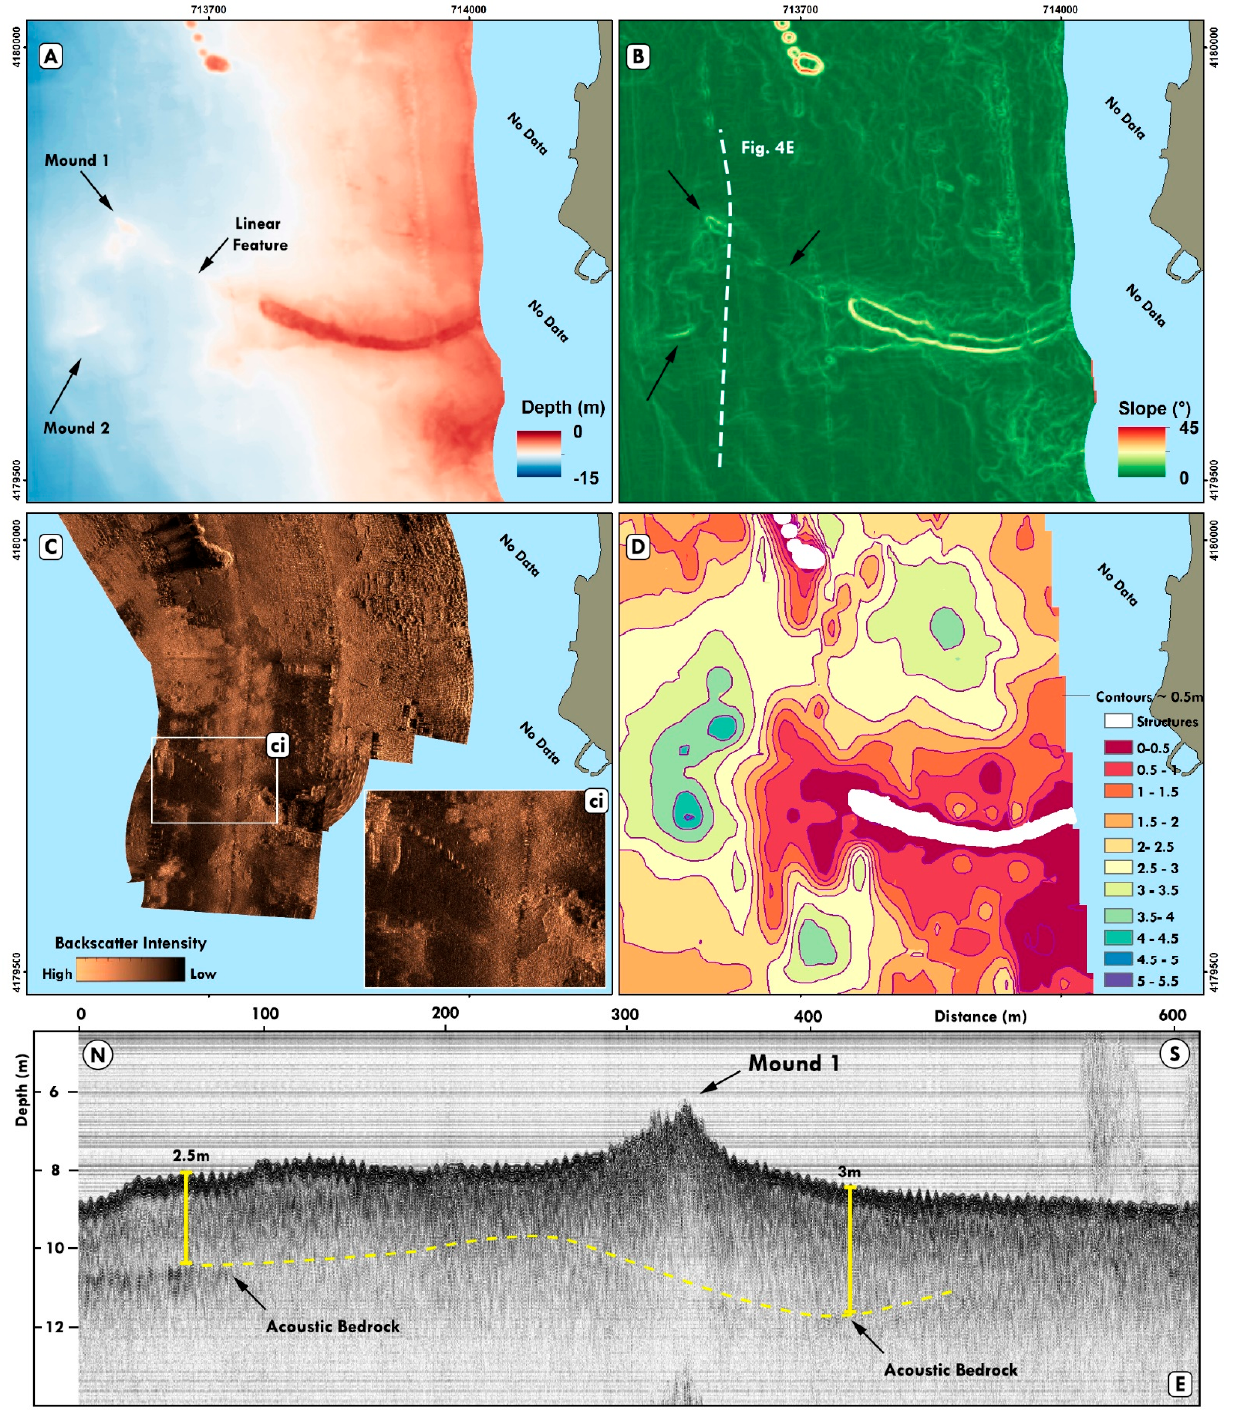
Figure 5. Geophysical data from the southern area (iii) as delimited in Figure 1. ( A ) bathymetric map, ( B ) slope map, ( C ) backscatter intensity map, ( D ) sediment thickness map, ( E ) seismic profile (location is shown in Figure 5C).